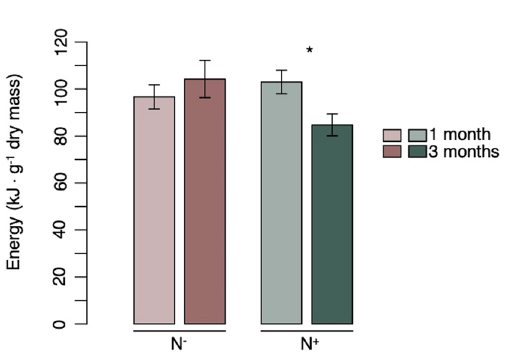
Figure 4. Effect of nutrient enrichment through time on energy content in the tissues of L. balthica . Average energy content (kJ g −1 dry mass) for nutrient conditions following one and three months exposure. Pair-wise contrasts showed a significant difference between one and three months of exposure under enriched nutrient conditions (p < 0.05) as indicated by the asterisk. Histograms represent mean values, and error bars correspond to standard